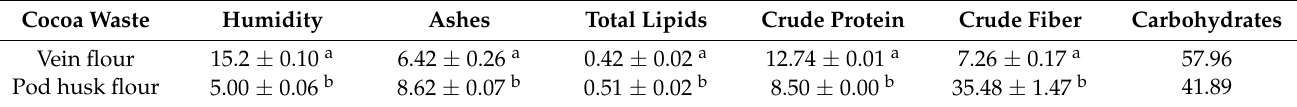
Table 2. Proximal composition in flour from vein and pod husk of cocoa